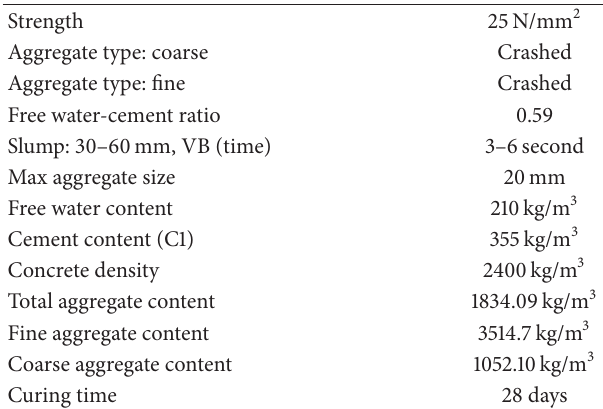
Table 2: Concrete properties and mix